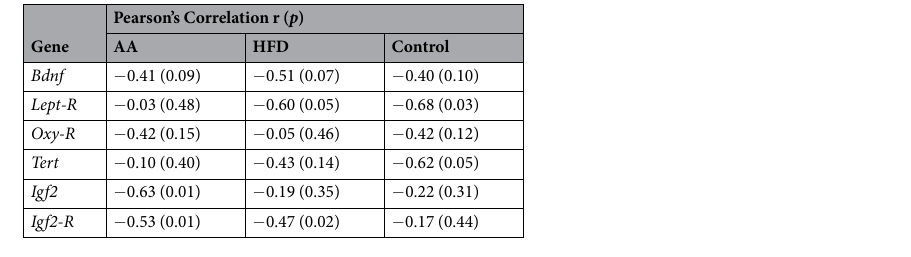
the HFD group. As male obesity has been linked to reduced fertility and reproductive health 69 , the increased methylation of the Tert promoter in sperm of HFD fathers and their sons may be contributing to their sperm health and reduced reproductive success. Of importance, the mTBI did alter promoter methylation in sperm of sons born to AA fathers, increasing methylation, thereby reducing expression of Tert . Although this requires additional investigation, sons with a history of mTBI who were born to older fathers, may transmit additional risk to subsequent generations. In addition, normal mammalian development is dependent upon a small number of imprinted genes that are specifically expressed from either the maternal or the paternal genome 70, 71 . Imprinting relies on a small group of genes that are epigenetically marked, often via DNA methylation by de novo DNA methyltransferases, to establish parent-of-origin-specific gene expression 71 . Igf2 is a paternally imprinted gene and should therefore be silenced in male gametes. As expected, we found that the Igf2 promoter region in sperm from both fathers and sons, across all treatment conditions, was between 85–95% methylated, suggesting gene silencing. Conversely, the Ifg2-R is maternally imprinted, silenced in female gametes, and therefore should be expressed in our male rats. In support of this, we found methylation of the promoter region for the Igf2-R to range from 30–75% across our treatment groups. Furthermore, similar to Bdnf, Lept-R, Oxy-R and Tert , Igf2-R methylation was influenced by paternal